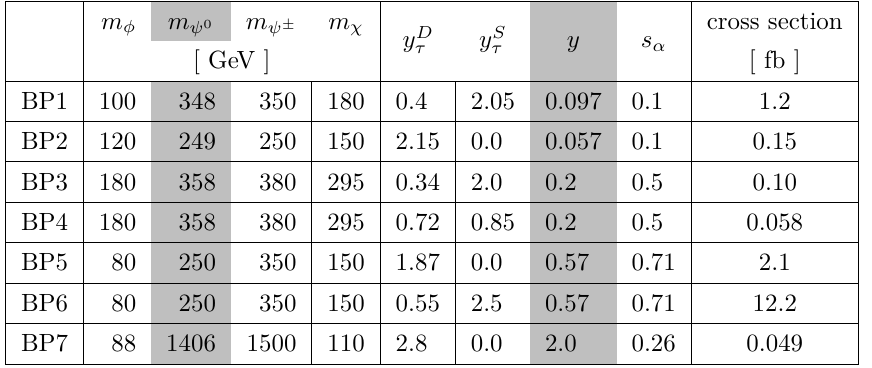
Table 3 . Relic density allowed benchmark points for analysis of 3 τ ν 2 φ channels. y D The shaded columns are for the dependent model